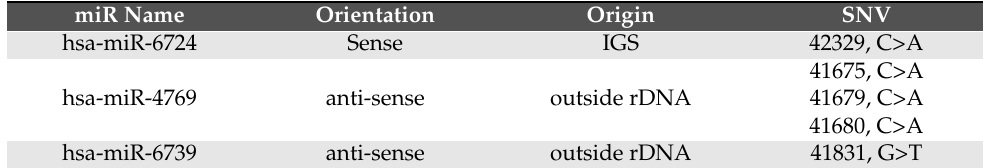
Table 4. Three miRs corresponding to the discovered